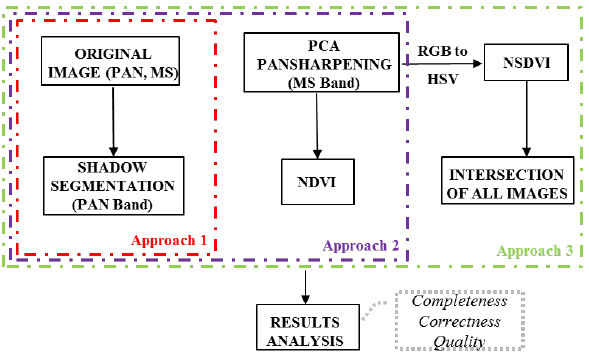
Figure 1. Diagram of approaches developed in the